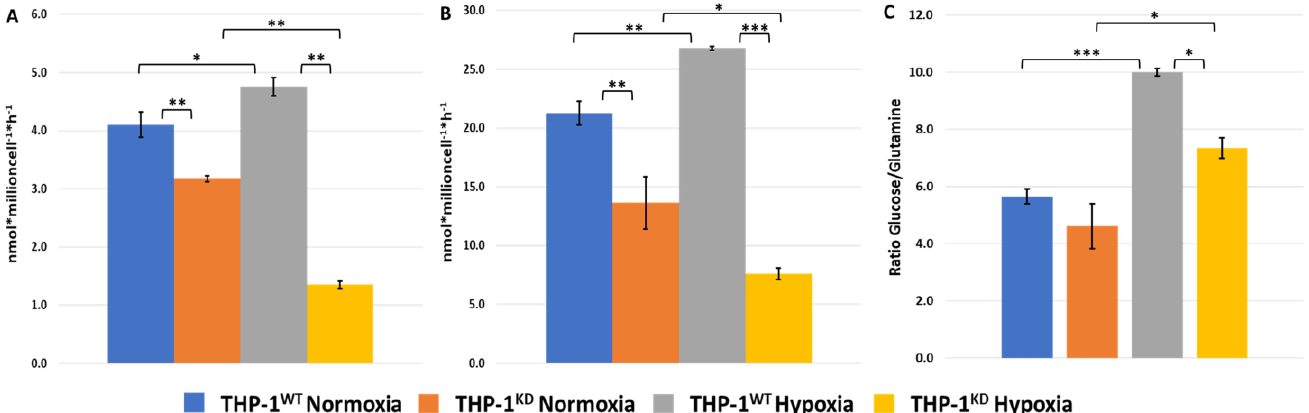
Figure 4. Loss of TKTL1 impairs hypoxia response. Changes in glutamate ( A ) and in glutamine ( B ) concentrations in incubation medium, normalized by cell number and incubation time. Glutamate and glutamine concentrations were measured in incubation medium of THP-1 WT and THP-1 KD cells incubated for 48 h, in both normoxic and hypoxic conditions. ( C ) Ratio of change in glucose per change in glutamine concentration. Data represented are mean ± SD (n = 3). Statistically significant differences in all panels were determined by two-tailed independent sample Student’s t -test: p < 0.05 (*). p < 0.01 (**). p < 0.001 (***).